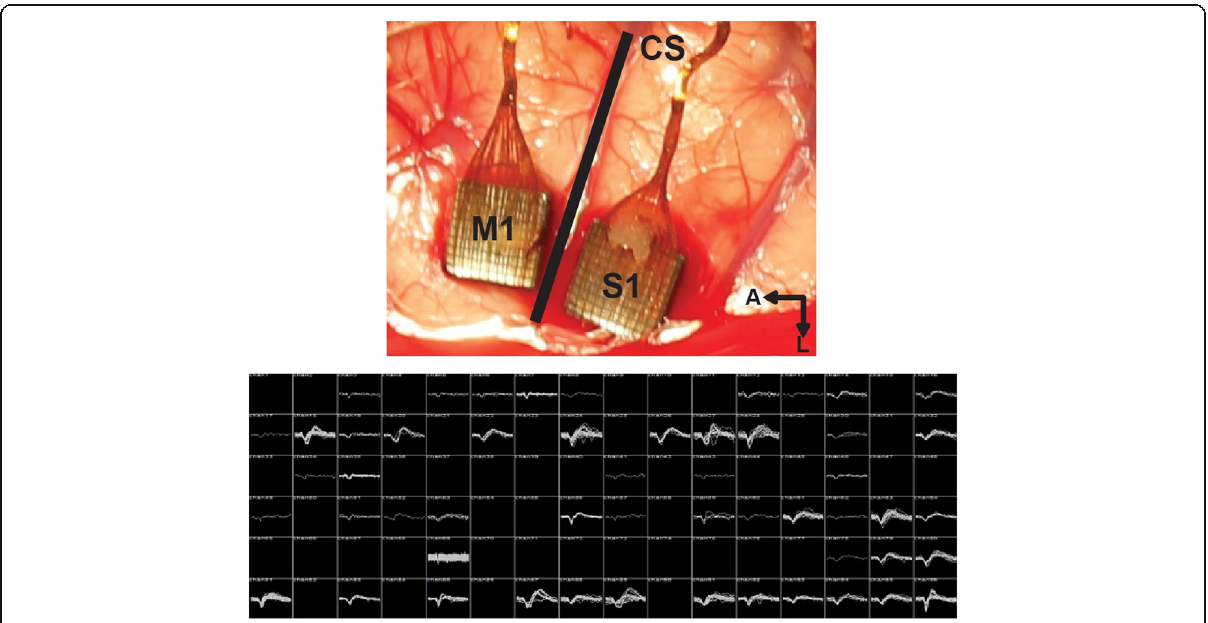
Fig. 5 (Top) Surgical photo of Utah arrays implanted in the motor and sensory cortex of a rhesus macaque. A – anterior, L – lateral, CS – central sulcus. (Bottom) Spike panel recorded from the M1 array using a Cerebus Neural Signal Processor (Blackrock Microsystems) illustrating the number of single units and their quality. Data from this monkey was used in later analysis to validate the device offline and in